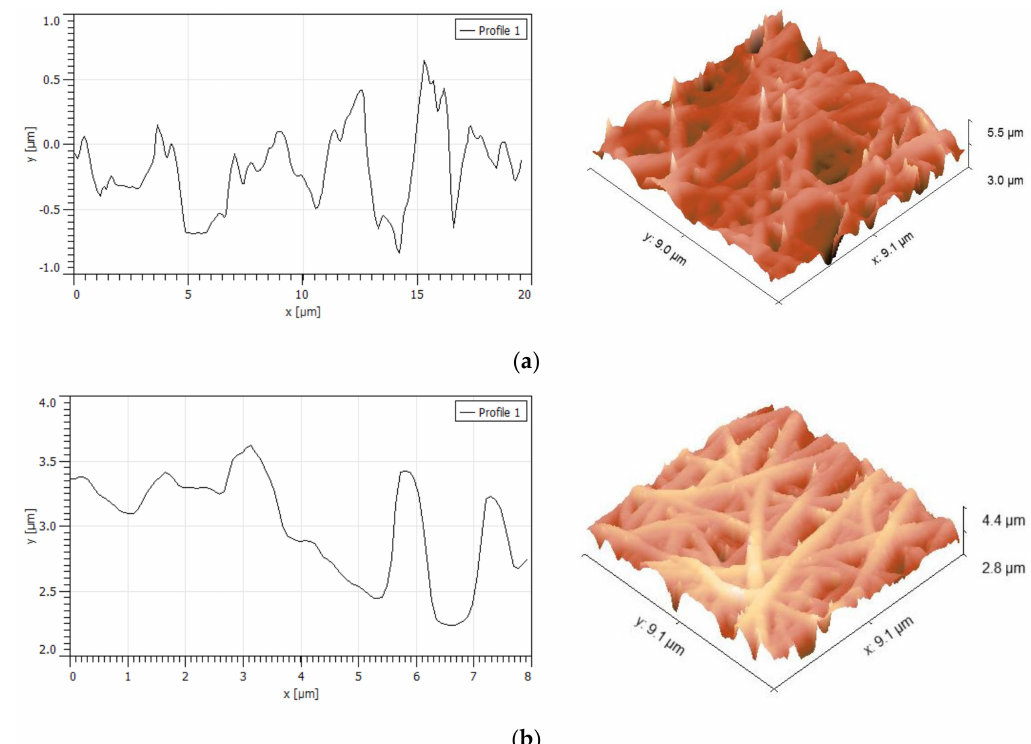
Figure 3. AFM morphology and roughness profiles of the CS surface ( a ) and the ALG&CNW surface ( b ) of the of the bilayer CS–ALG&CNW sca ff